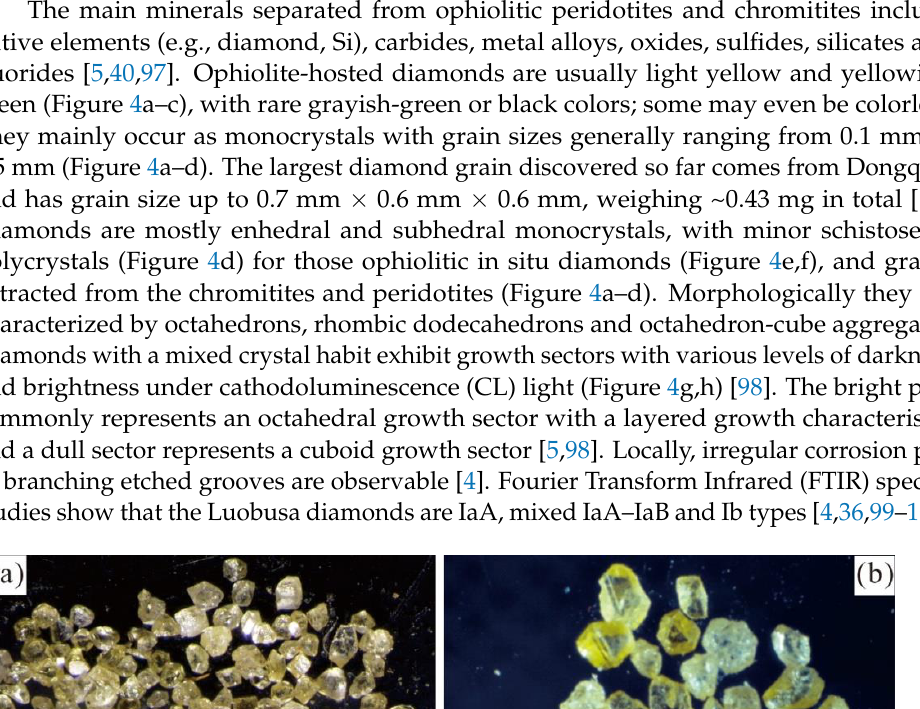
Figure 4. Photomicrographs of ophiolite-hosted diamonds from chromitite and peridotite. ( a ) Di- amonds from the Ray-Iz chromitite, Russia [17]; ( b ) diamonds from the Pozanti-Karsanti (Aladag) chromitite, Turkey [32]; ( c ) diamonds from the Ray-Iz chromitite, Russia [24]; ( d ) backscattered secondary electron image showing polycrystal striations on the diamond surface [20]; ( e , f ) chro- mite hosted in an in situ diamond [24]; ( f ) in situ diamonds hosted by chromitite from the Luobusa